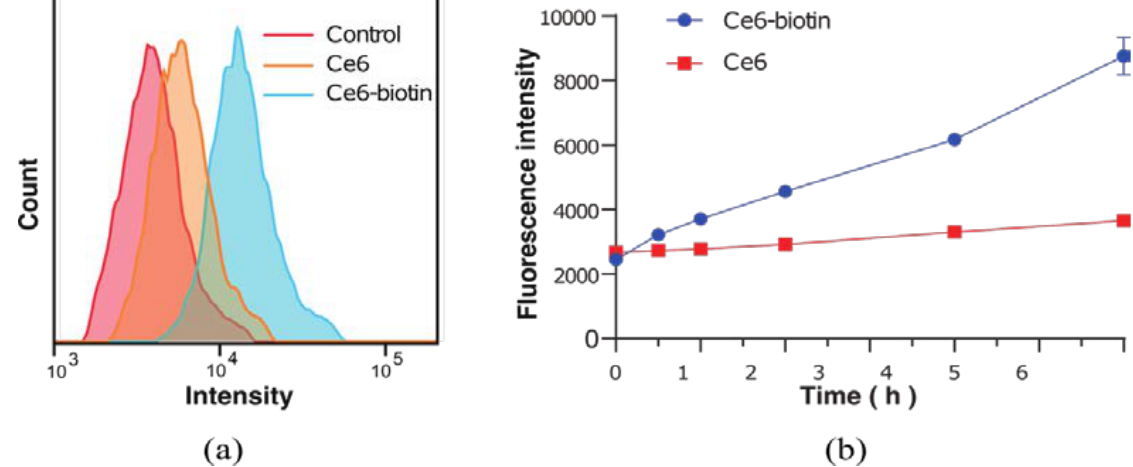
Figure 4. ( a ) Flow cytometry analyses of HeLa cells incubated with Ce6 and Ce6-biotin for 6 h. ( b ) Uptake isotherms of Ce6 and Ce6-biotin toward HeLa cells incubated for 0.5, 1, 2, 4, and 6 h, respec- tively.